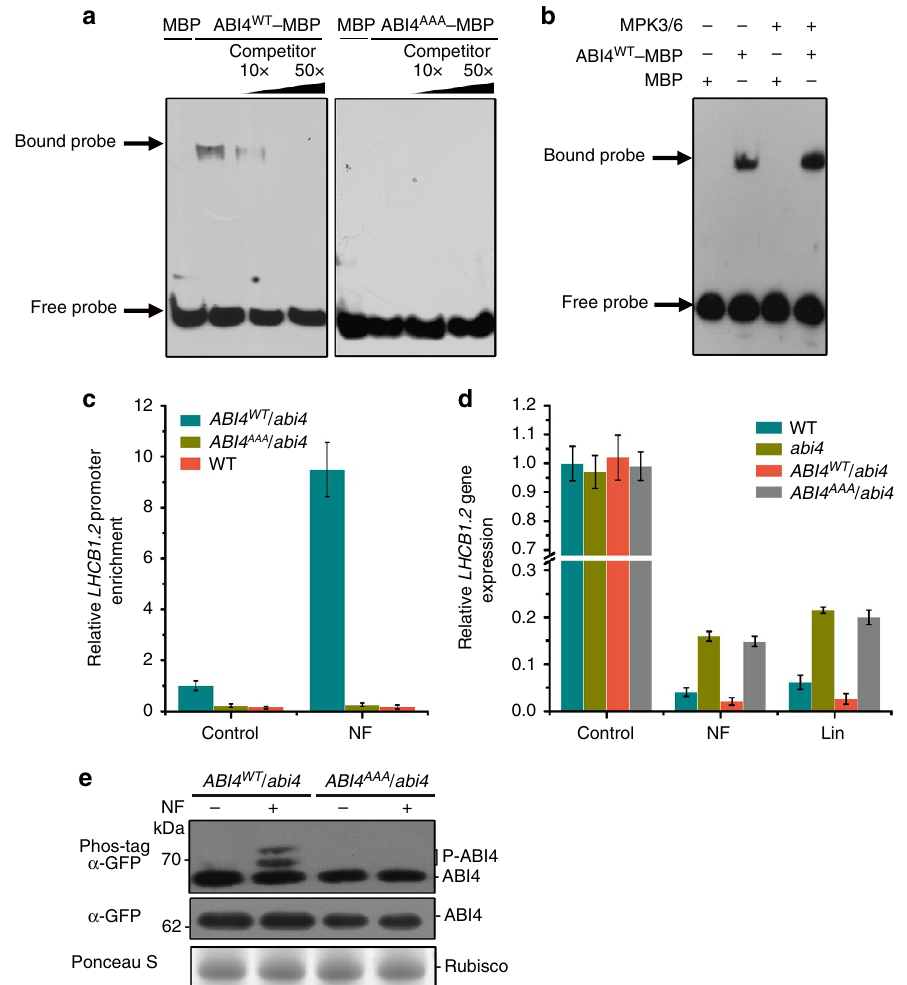
Figure 3 | Phosphorylation of ABI4 is required for its function during the retrograde response. ( a ) The effect of mutations of phosphorylation sites on ABI4 DNA-binding activity by EMSA analysis. Recombinant ABI4 WT and ABI4 AAA proteins were incubated with a biotin-labelled LHCB promoter probe and detected by chemiluminescence. Increasing amounts of unlabelled competitors were used for competition and maltose-binding protein (MBP) served as a negative control. ( b ) ABI4 binding activity to the LHCB promoter upon MAPK-mediated phosphorylation. After incubation with activated MPK3 and MPK6 (equal mixture), phosphorylated ABI4 was subject to EMSA. MBP served as a negative control. ( c ) ChIP-qPCR analysis of ABI4 binding to the LHCB promoter in ABI4 WT /abi4 and ABI4 AAA /abi4 transgenic plants. Chromatin was isolated from 7-day-old seedlings in the presence or absence NF treatment. The GFP-tagged ABI4–chromatin complex was immunoprecipated using anti-GFP antibody. The relative DNA enrichment was determined by real-time PCR using primers specific to the promoters of LHCB1.2 . A control reaction was processed using wild-type Arabidopsis samples. Values shown are means ± s.d. of three biological replicates. ( d ) Impact of lincomycin (Lin) and NF treatments on LHCB1.2 transcript levels in WT, abi4 , ABI4 WT /abi4 a nd ABI4 AAA /abi4. Seven-day-old seedlings of WT, abi4 , ABI4 WT /abi4 a nd ABI4 AAA /abi4 grown on 1/2 MS media containing 500 m M Lin or 5 m M NF were harvested and RNA was isolated. The LHCB mRNA levels were determined by qRT–PCR. The relative transcript level of LHCB in seedlings grown on Lin or NF medium were normalized to values of control seedlings grown on 1/2 MS medium. Values shown are means ± s.d. of three biological replicates. ( e ) Phosphorylation of ABI4 in seedlings after NF treatment. Total protein was extracted from ABI4 WT /abi4 and ABI4 AAA /abi4 seedlings at 0.5h after NF treatment and separated in a Phos-tag SDS–PAGE followed by immunoblot analysis with anti-GFP antibody (top). Total protein extracts were separated by SDS–PAGE and the ABI4 protein was immunodetected with anti-GFP antibody at the same time (middle). Ponceau S staining was used to demonstrate equal loading